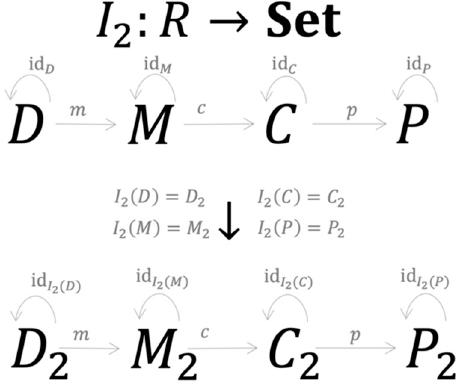
Figure 6. The mapping process of the second R-instance.